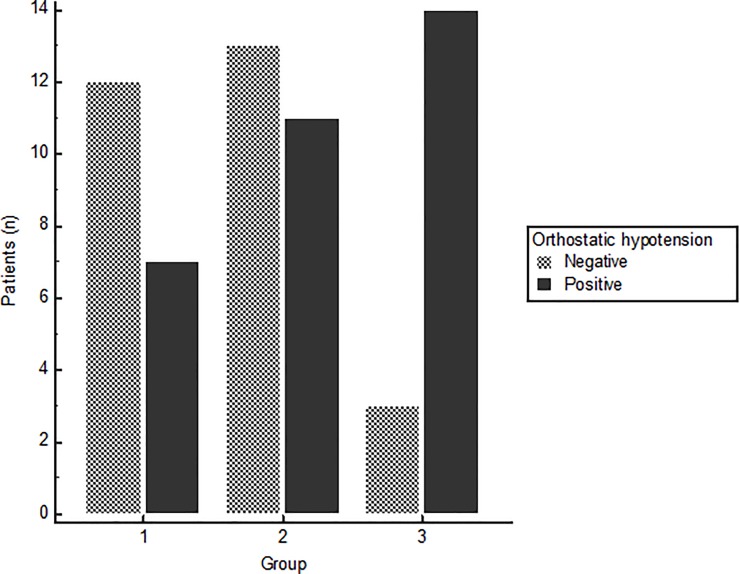
Frequency of orthostatic hypotension.The frequency of orthostatic hypotension is highest in group 3 and tends to increase from group 1 to group 3.